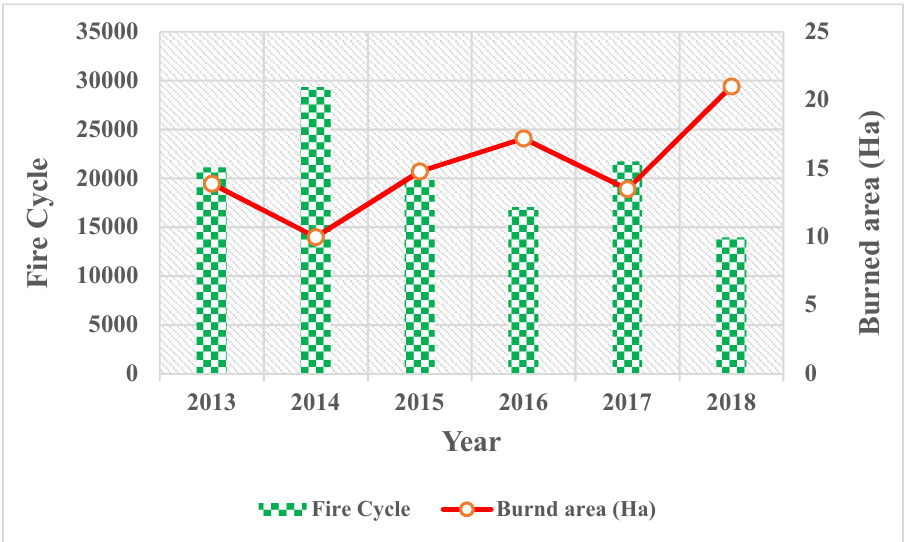
Figure 5. Result of the fire cycle.